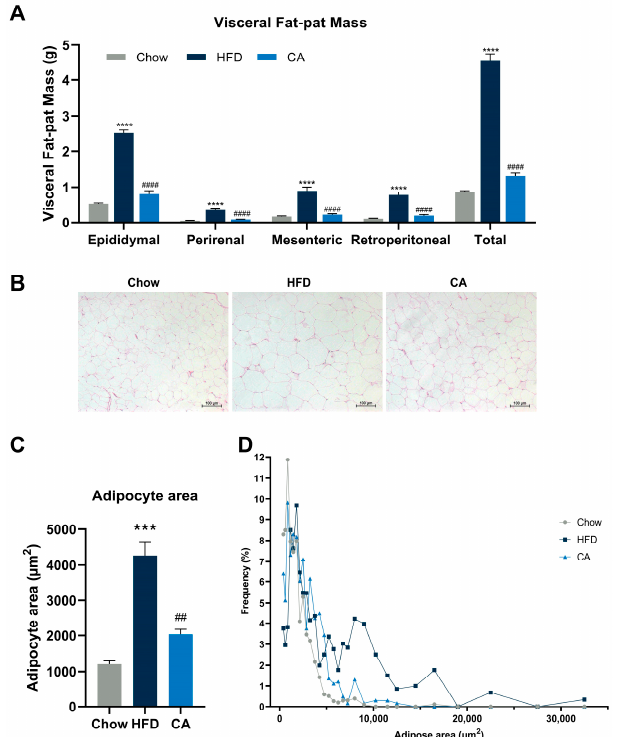
Figure 2. CA prevents HFD-induced adipocyte hypertrophy in mice. ( A ) The weight of visceral fat pads. ( B ) H&E-stained sections for eWAT, bar = 100 μ m. ( C ) Mean cross-sectional areas of adipo- cytes. ( D ) Frequency distribution of adipocyte cross-sectional areas in eWAT. Data are expressed as means ± SEM ( n = 8). **** p < 0.0001 vs. Chow group, *** p < 0.001 vs. Chow group, #### p < 0.0001 vs. HFD group, ## p < 0.01 vs. HFD